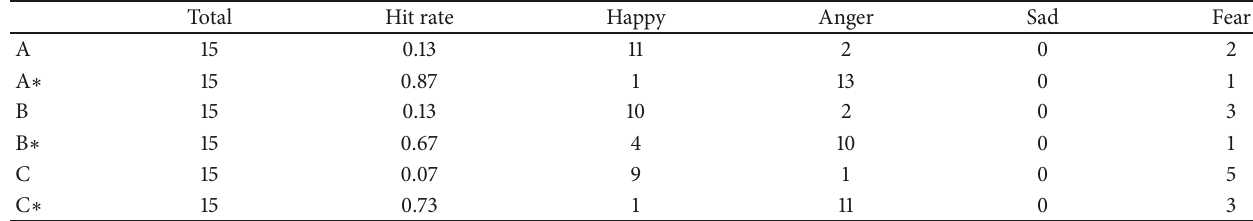
Figure 5: The induced experiment process. Notes: A: normal driving; A ∗ : encountering adjacent vehicle interference; B: no need to wait for the red light; B ∗ : encountering the traffic light frequency; C: traffic flow is normal; C ∗ : encountering traffic congestion. Table 1: The emotional differentiation degree in different